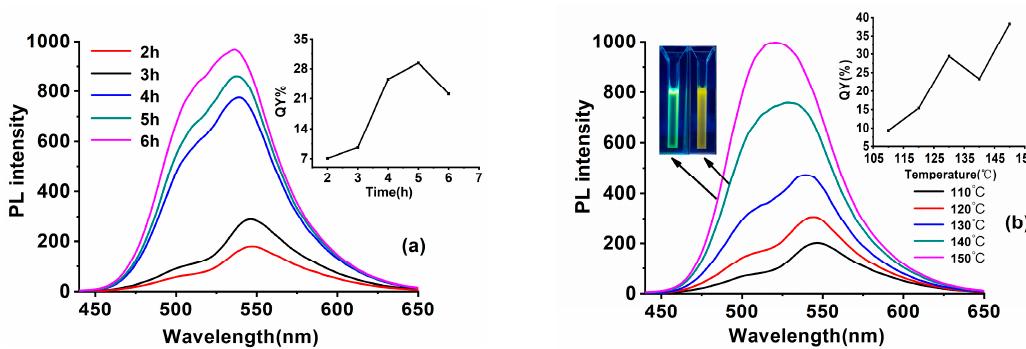
Figure 3. PL spectra of SiQDs synthesized with CC and Na-citrate at ( a ) different reaction time and ( b ) at different reaction temperature. Inset: the picture shows the increasing trend of QYs and the photos are of g-SiQDs and y-SiQDs.